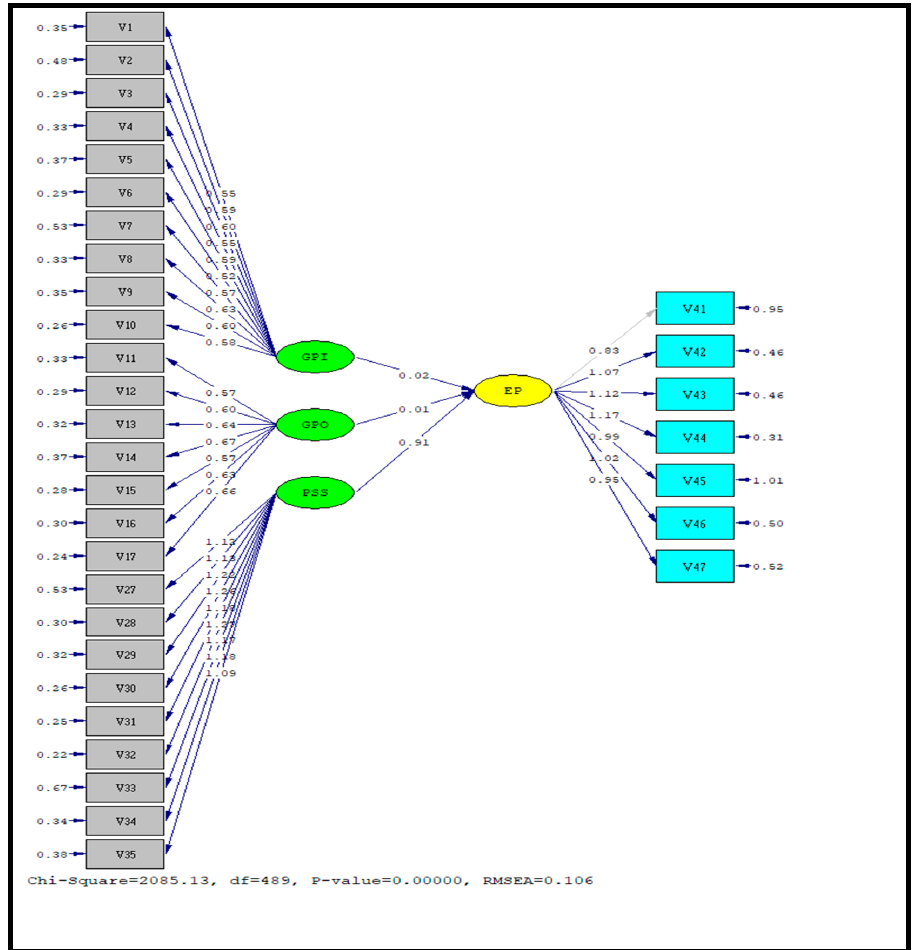
Figure 3. SEM Results.